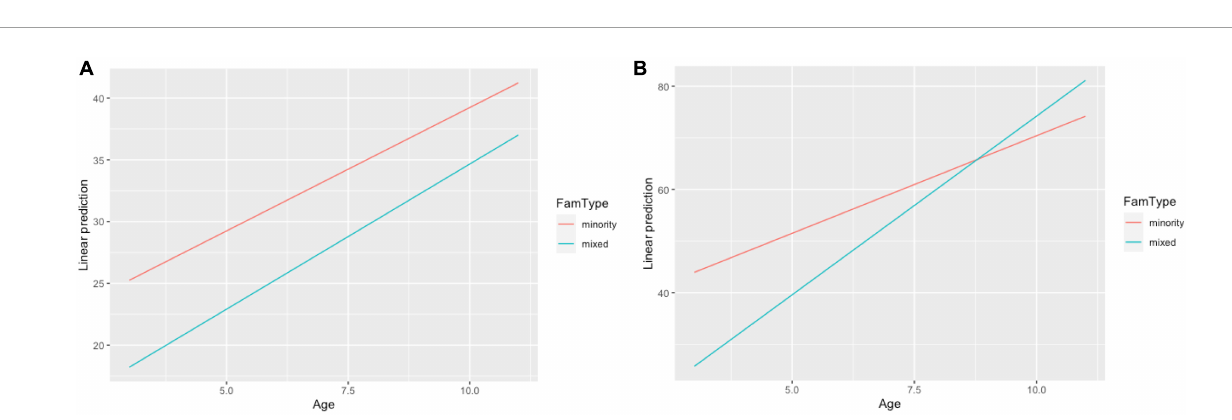
FIGURE3 Linear trends for the development of number of different words (NDW) (A) and total number of words (TNW) (B) as a function of age and family type in Russian heritage language